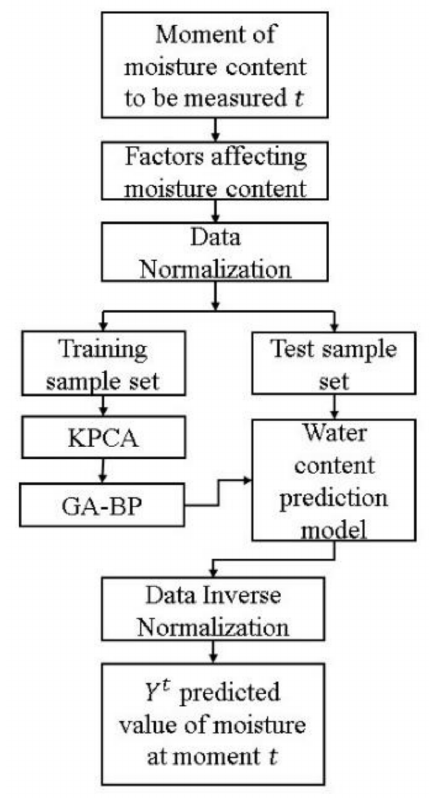
Figure 4. Moisture prediction strategy